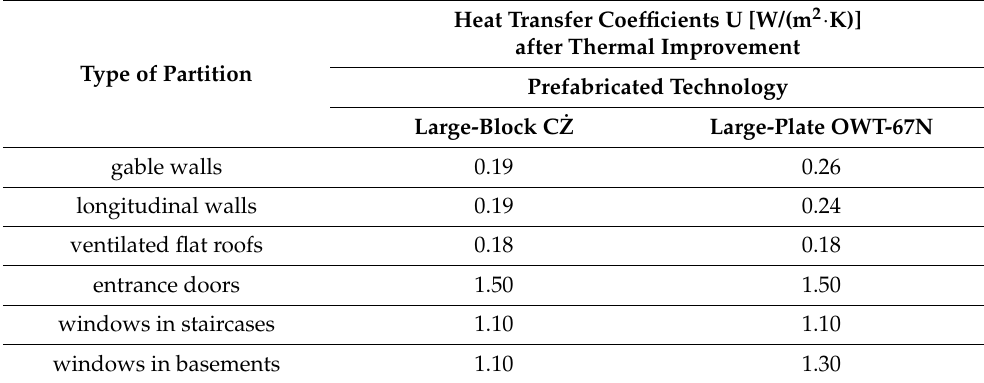
Type of Partition